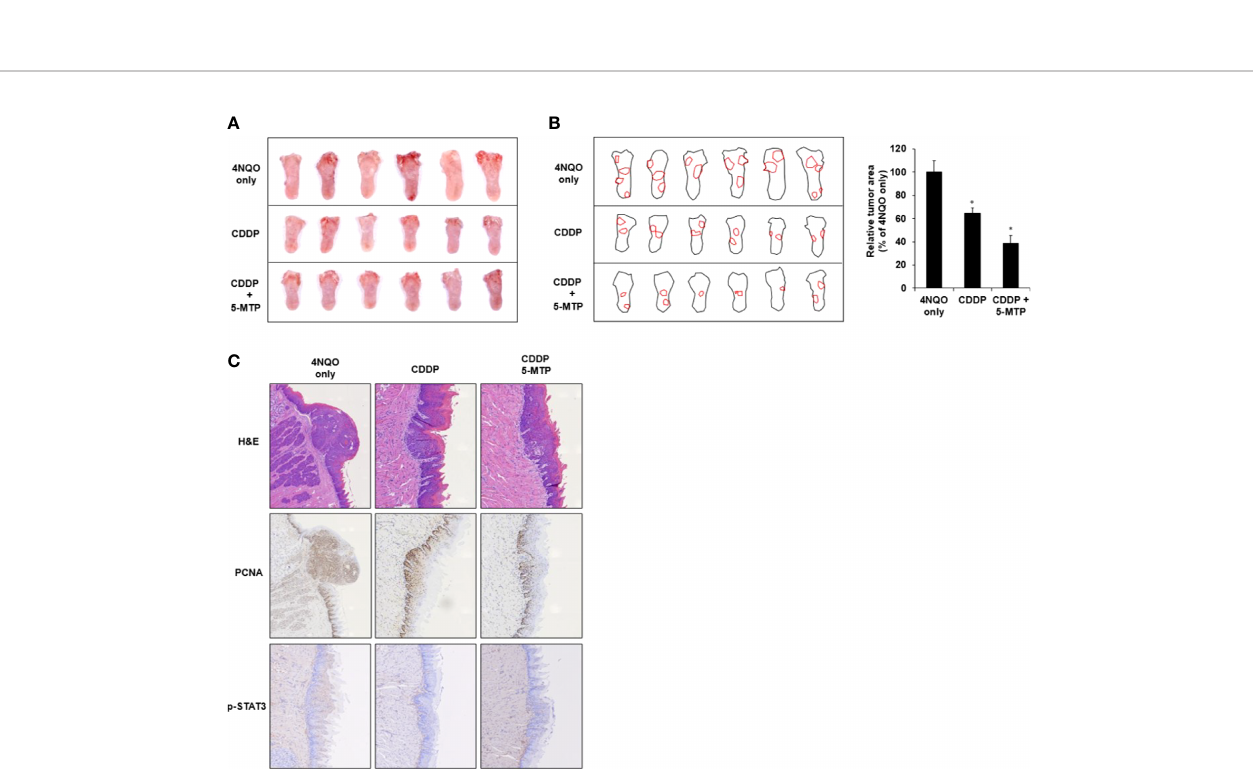
FIGURE 4 | Additional inhibitory effect of the combination treatment of Cisplatin (CDDP) and 5-methoxytryptophan (5-MTP) in 4NQO-induced tongue oral squamous cell carcinoma (OSCC) mouse model. (A) Morphological observation of the DMSO- or drug-treated group in 4NQO-induced cancer mouse model. (B) Digital outlines of representative tongues of DMSO- or drug-treated mice. Asterisks indicate signi fi cant difference in drug-treated group singly in comparison with 4NQO-treated group. *P < 0.05 (C) hematoxylin – eosin or immunohistochemical staining with PCNA and p-STAT3 antibodies of tongue cancer with DMSO or drug treatment.